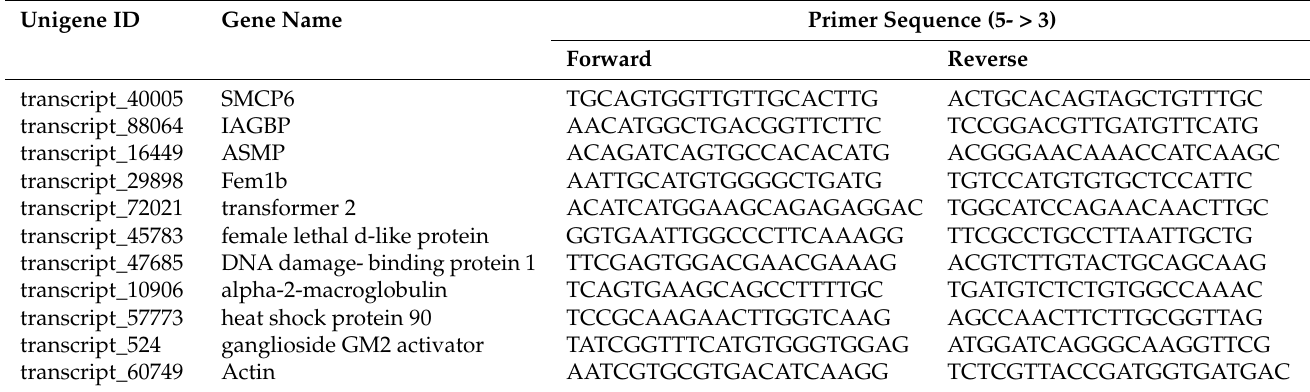
Table 1. Sequences of primers used for gene differential expression